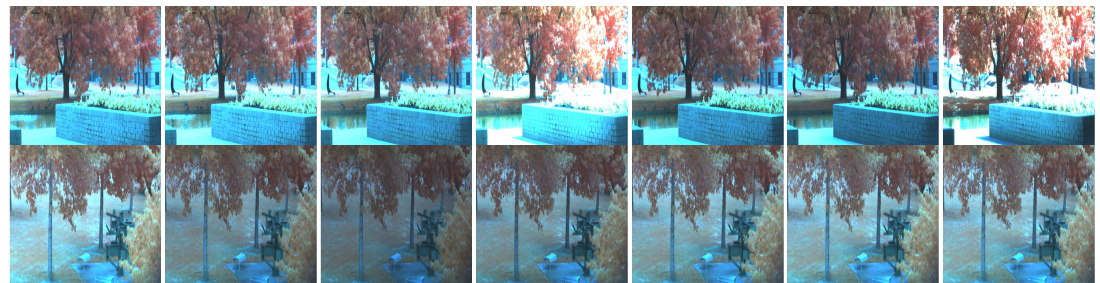
Figure 3. Sample images at different time instants from the AAMU hyperspectral image datasets (top: Scene-1, and bottom: